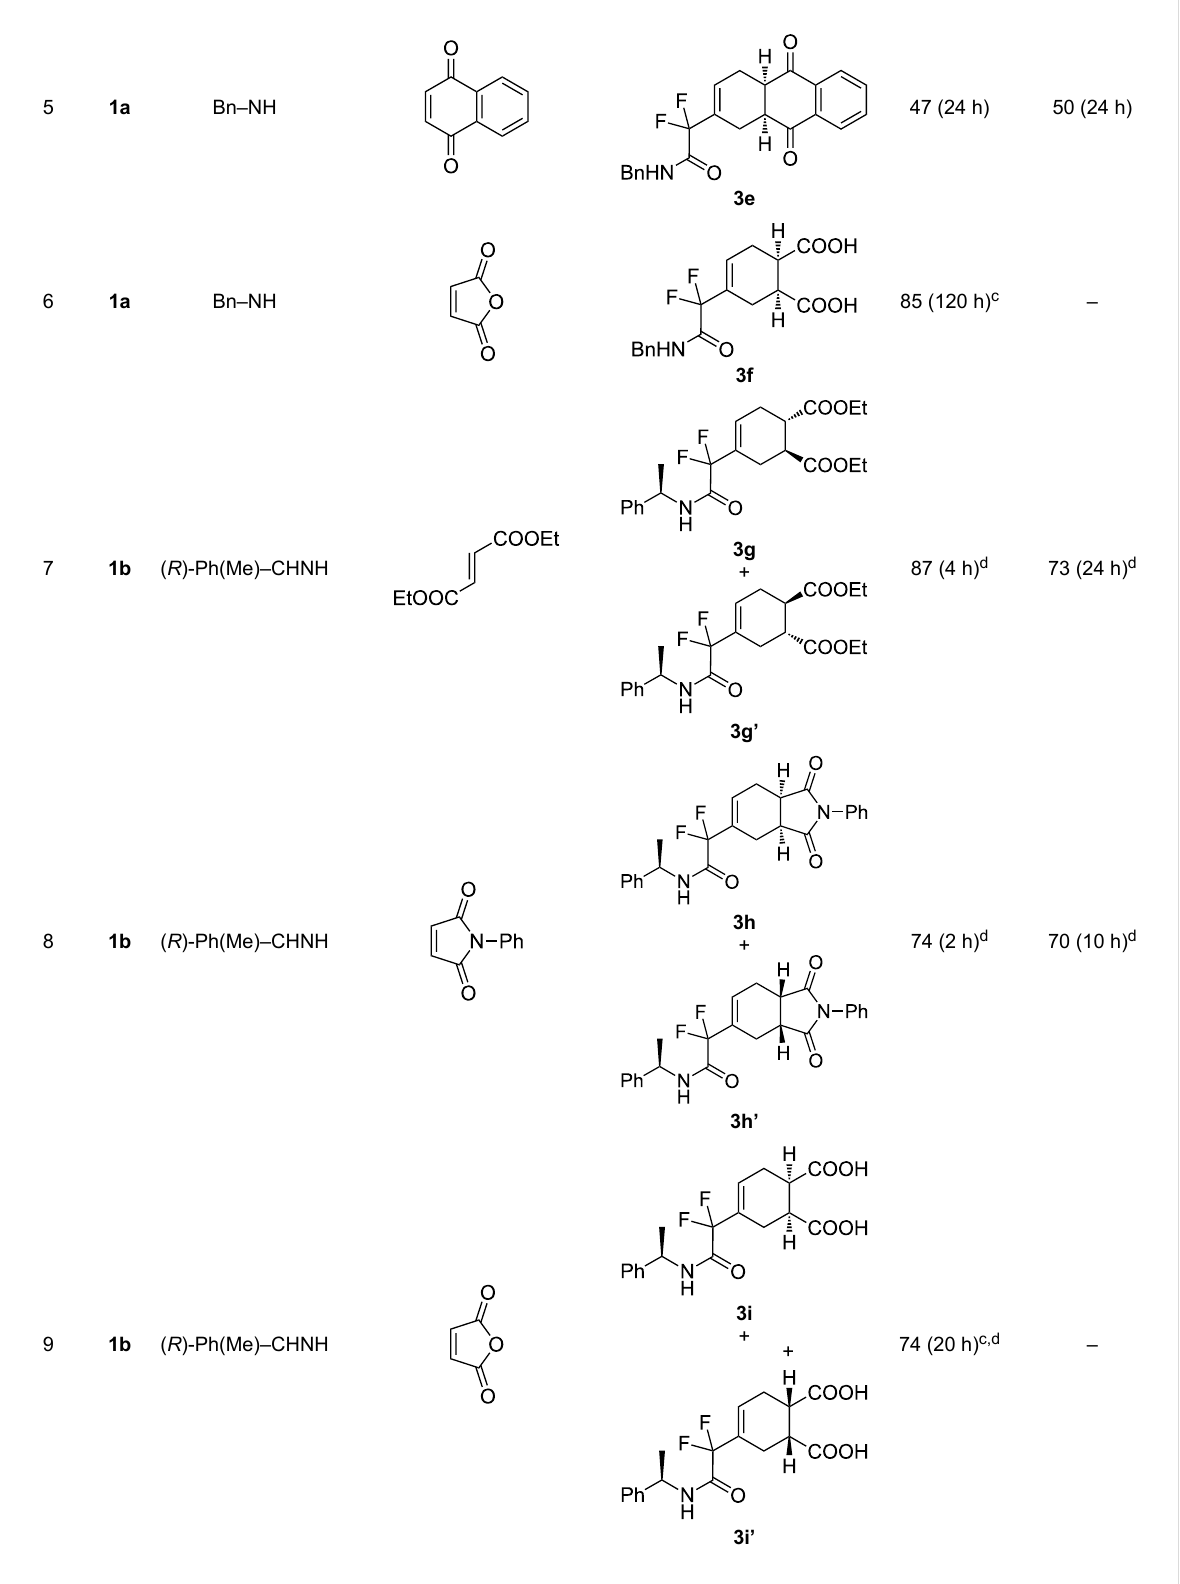
Table 1: Preparation of compounds 3 by one-pot CEYM–Diels–Alder reaction of substrates 1 (method A).